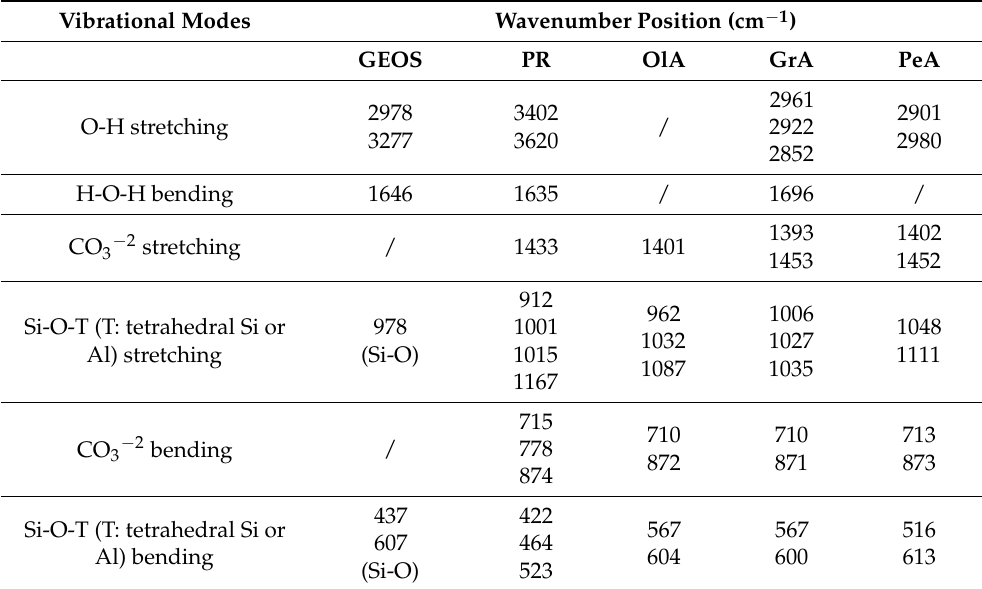
Table 3. Band assignments of raw biomass ash, clayey soil, and liquid activator from FT-IR analysis. Bands were assigned according to [26–29].